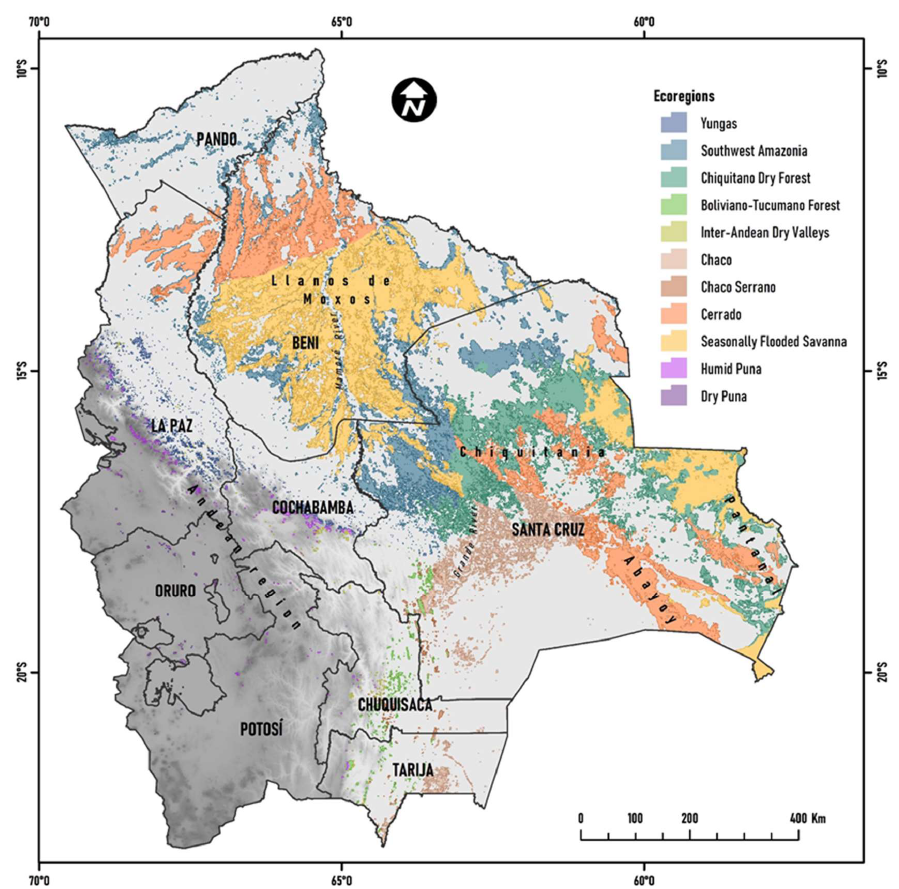
Figure 1. Wildfire scars (2001–2021) relation to the ecoregions of Bolivia and areas of interest men- tioned in this research. Due to this complex topography, Bolivia concentrates 12 important ecoregions, each with a high diversity of vegetation formations [26]. Seven ecoregions are located in the Andean and sub-Andean regions (Figure 1): Northern Puna, Southern Puna, Inter-An- dean Dry Valleys, Prepuna, Yungas, Boliviano-Tucumano Forest, and Chaco Serrano [26]. Five ecoregions are located in the lowland’s region (Figure 1): Southwest Amazonia, Chiquitano Dry Forest, Chaco, Cerrado, and the Seasonally Flooded Savanna (Pantanal and Llanos de Moxos) [26]. In the last two decades, a large proportion of the ecoregions have been impacted by fires [4], especially in the lowlands (Figures 1 and 2). Savannas are proportionally the ecosystems most affected annually by fires (42–62%) [4]. After fires, some of these ecosystems regenerate naturally (Figure 2) [14–17].